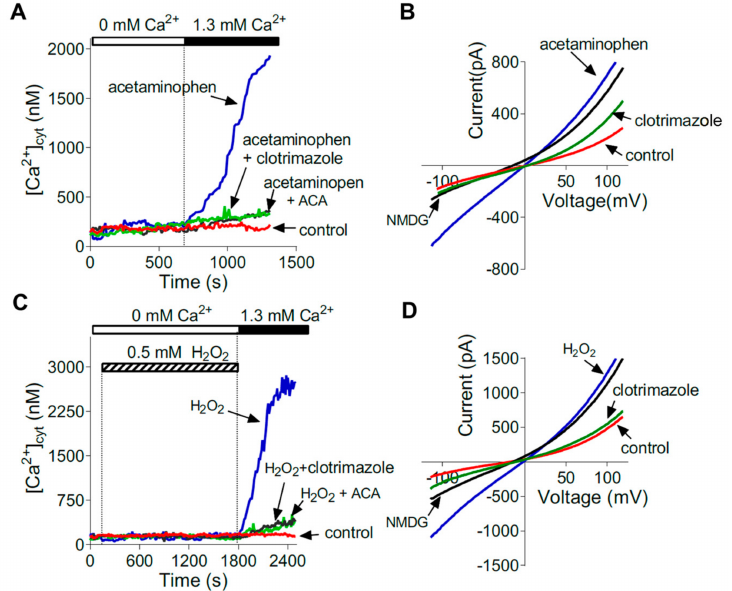
Figure 3. Evidence for the expression of functional TRPM2 channels in the plasma membranes of isolated mouse hepatocytes. TRPM2 channels were activated by acetaminophen ( A , B ) or H 2 O 2 ( C , D ). Ca 2+ entry was assessed by the increase in cytoplasmic Ca 2+ concentration ([Ca 2+ ] cyt ) ( A , C ) or by patch clamp recording of TRPM2 currents ( B , D ). Properties of the currents activated by ac- etaminophen and H 2 O 2 are similar to those observed for TRPM2 channels in other cell types. Evidence for TRPM2 channel activity is also provided by use of the TRPM2 inhibitors, clotrimazole, and N-(p-amylcinnamoyl) anthranilic acid (ACA). NMDG is N-methyl-d-glucamine. Reproduced with permission from Kheradpezhouh et al.